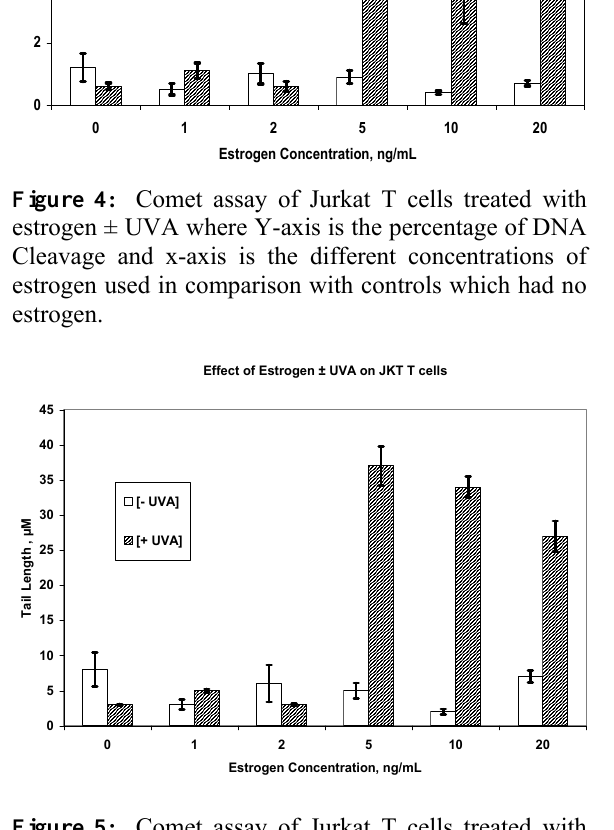
Figure 8 : Expression of bcl-2 and p53 by western blot of cells treated with estrogen in the presence and absence of ultraviolet